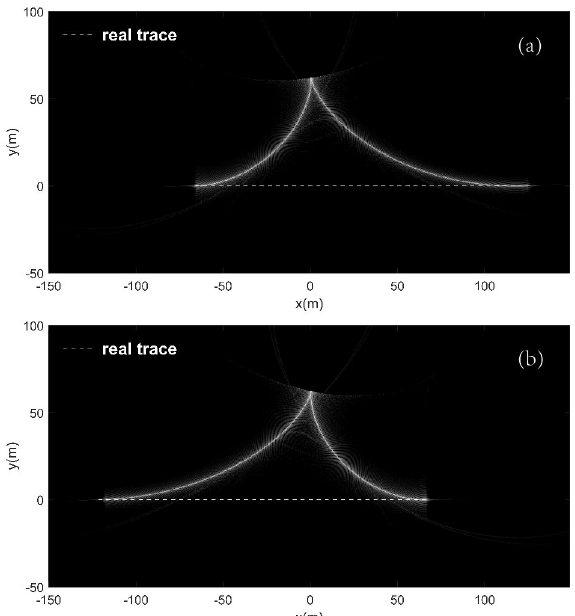
Figure 14. Target’s real trace and moving target SAR image. ( a ) is the deceleration target, and ( b ) is the acceleration target. Their speed (at t = 0) was − 4 m/s. For the acceleration and deceleration cases, the value of a t was − 0.1 m/s 2 and 0.1 m/s 2 ,